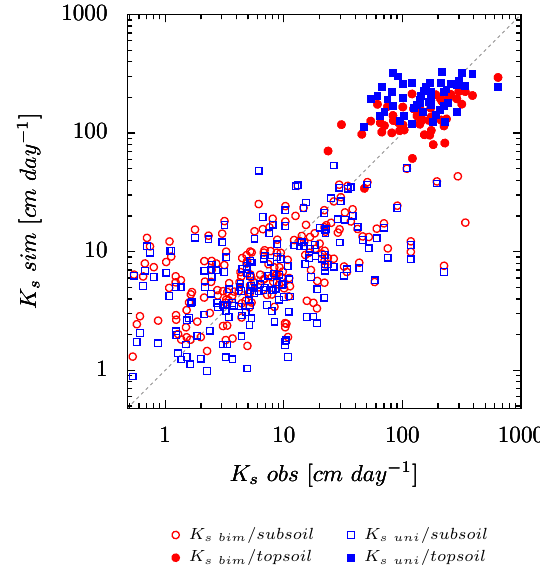
Figure 3. Plot between K s_obs against K s_bim and K s_uni for top- soil and subsoil. The dotted line refers to the 1 : 1